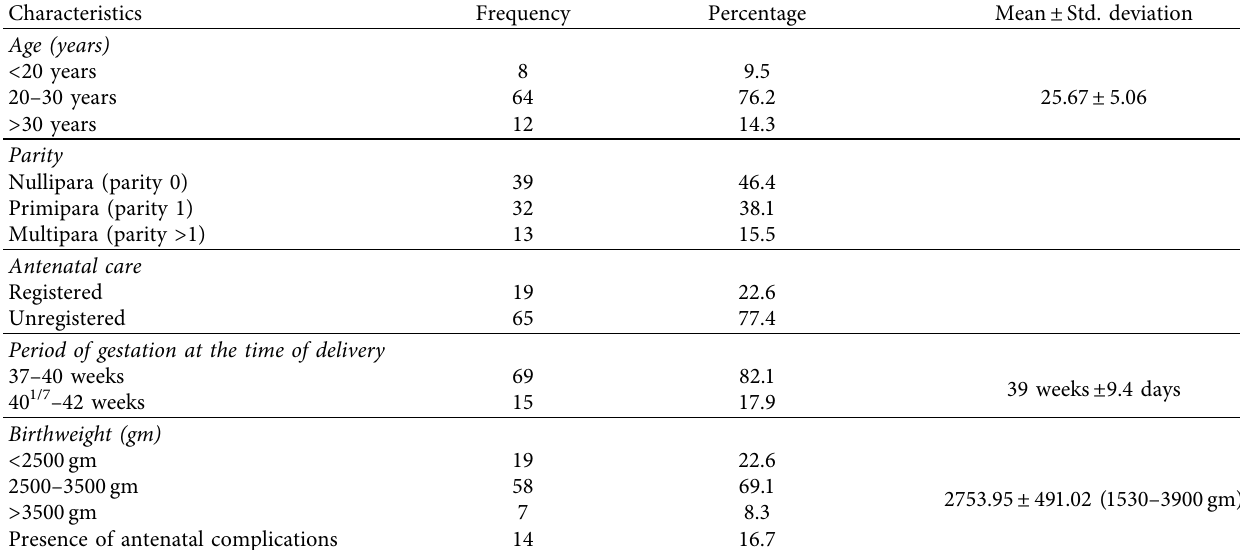
Table 1: Demographic and obstetric characteristics.